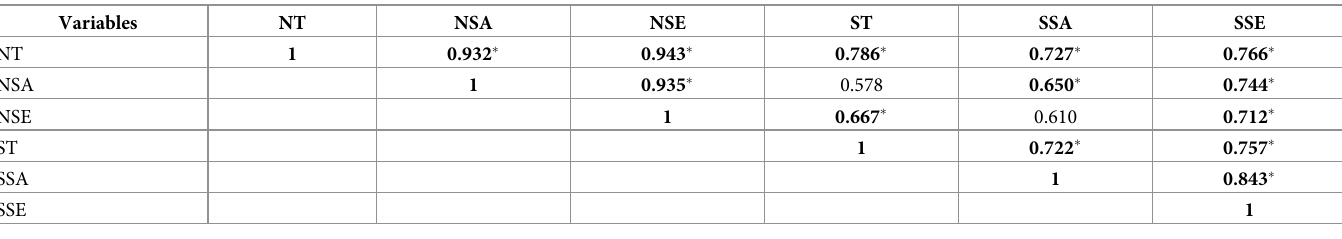
� . Correlation is significant at the 0.05 level (2-tailed).